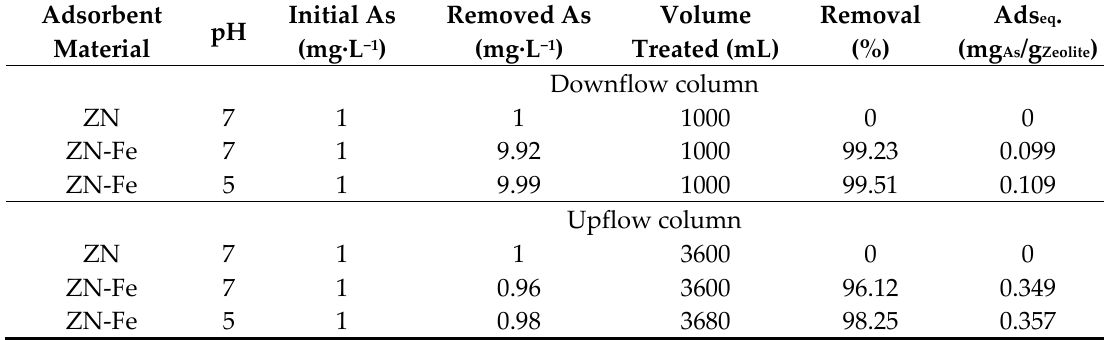
Table 3. Adsorption of ions As(V) in column system with natural and modified zeolite.